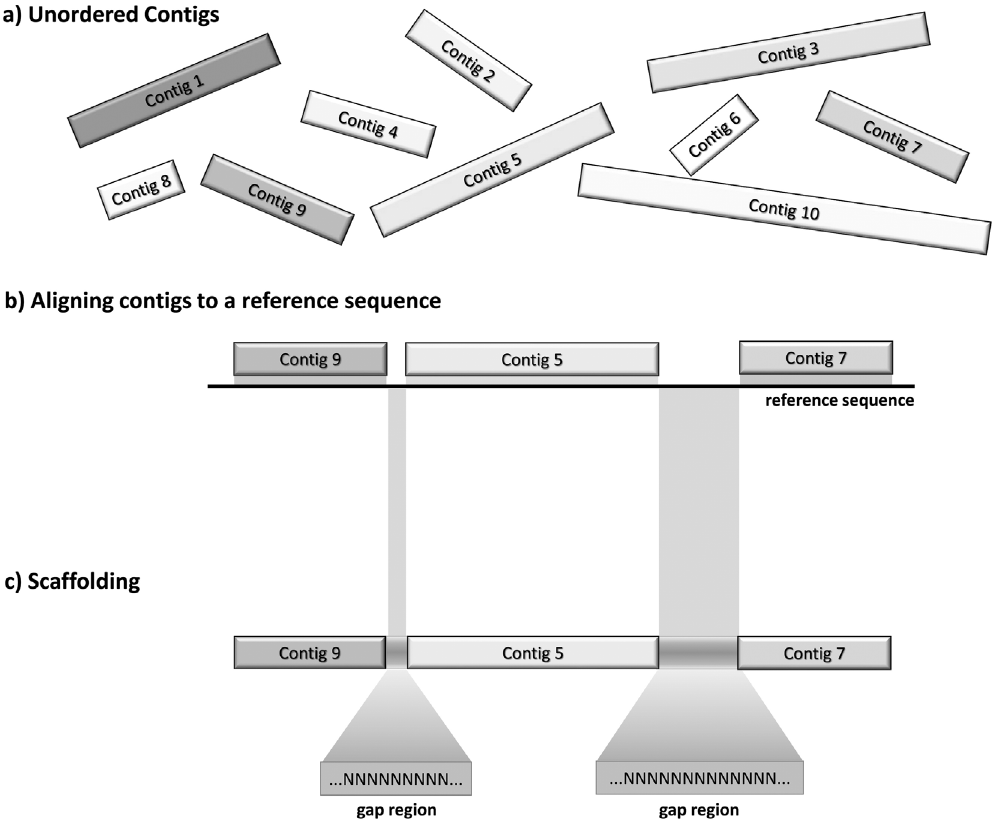
Figure 2 - Reference-based contig ordering. (a) The program takes a set of contigs (or scaffolds) and (b) aligns these to a reference genome to identify the most probable relative orientation of the sequences in the draft genome. (c) Regions not covered by the contigs represent gaps and may be sequencing/as- sembling artifacts or natural deletions. Based on the relative position of each contig, a scaffold is